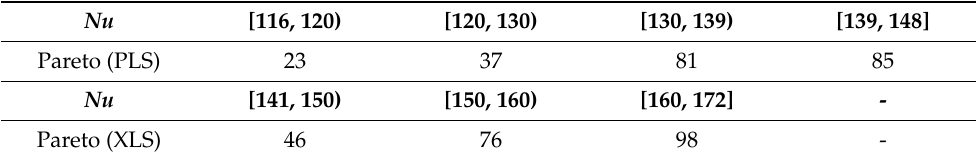
Table 3. The distribution for Pareto solutions of Nu for Op-I.